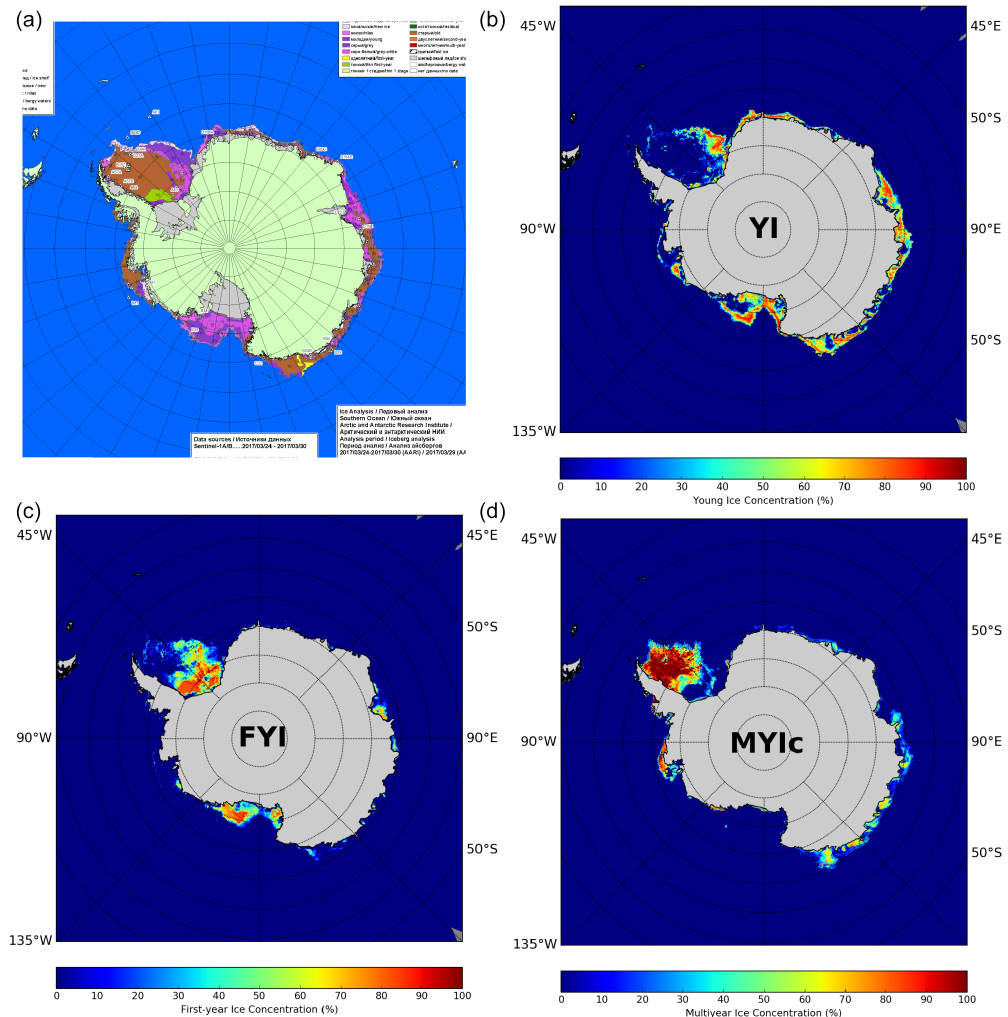
Figure 4. (a) Stage of development (SoD) chart by AARI, 30 March 2017; (b) YI concentration (ECICE), (c) FYI concentration (ECICE); (d) corrected MYI concentration (MYIc, ECICE and correction schemes). In the SoD chart, purple shades are YI (see the colour legend in the Appendix, Table B1), yellow and green shades are FYI, and brown and orange/red shades are MYI.